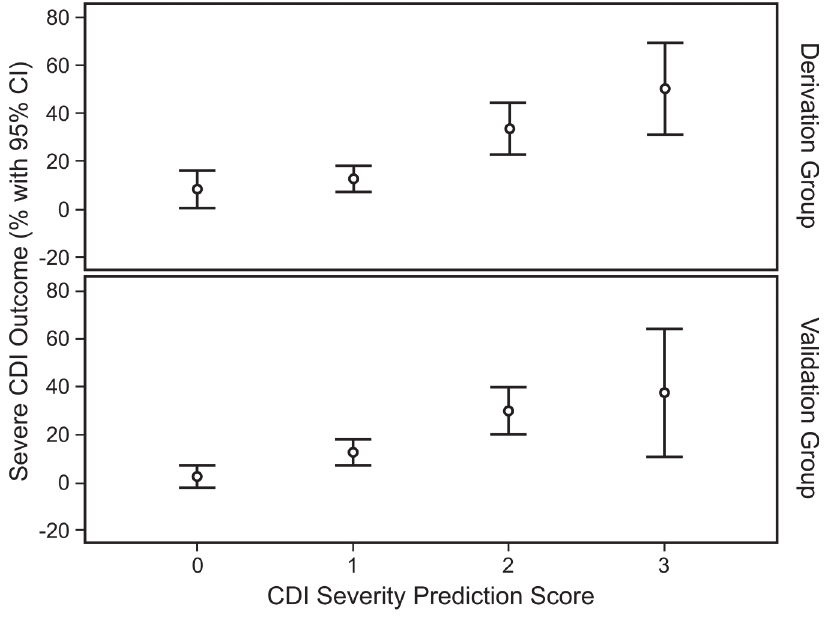
Fig 1. Association between CDI severity prediction score (0 to 3) and severe outcomes of CDI in the derivation (upper panel) and validation (lower panel) groups.